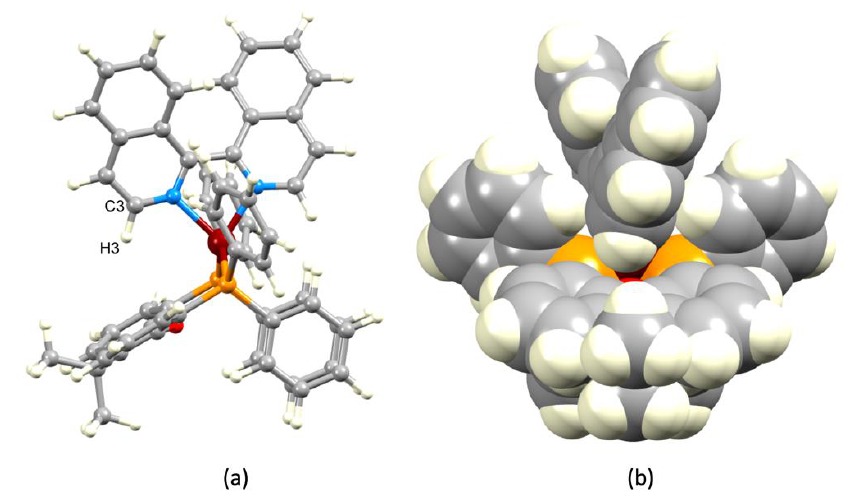
Figure 4. Calculated structure of the [Cu(xantphos)(biq)] + cation showing ( a ) a distorted tetrahedral Cu(I) coordination sphere and ( b ) accommodation of the C3–H3 unit of the biq ligand within the bowl-like cavity of the xanthene unit.